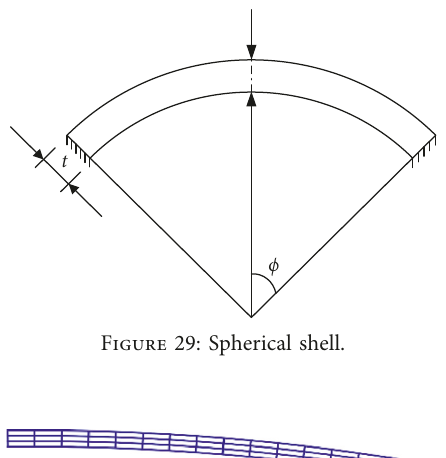
Figure 30: Domain discretization of half of the spherical shell.